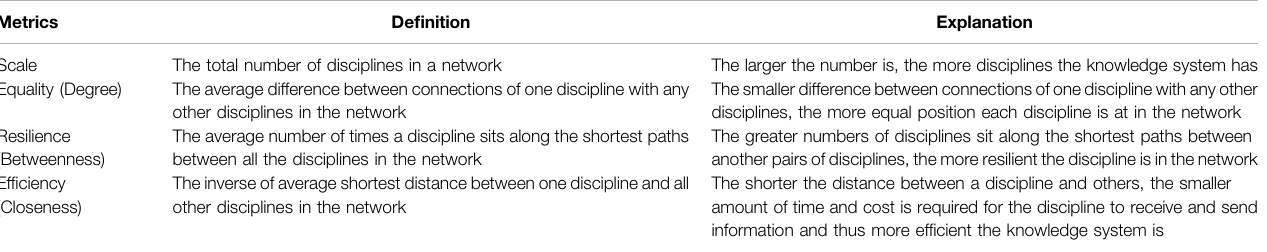
TABLE 1 | The metrics for scale and structure of a knowledge system on river